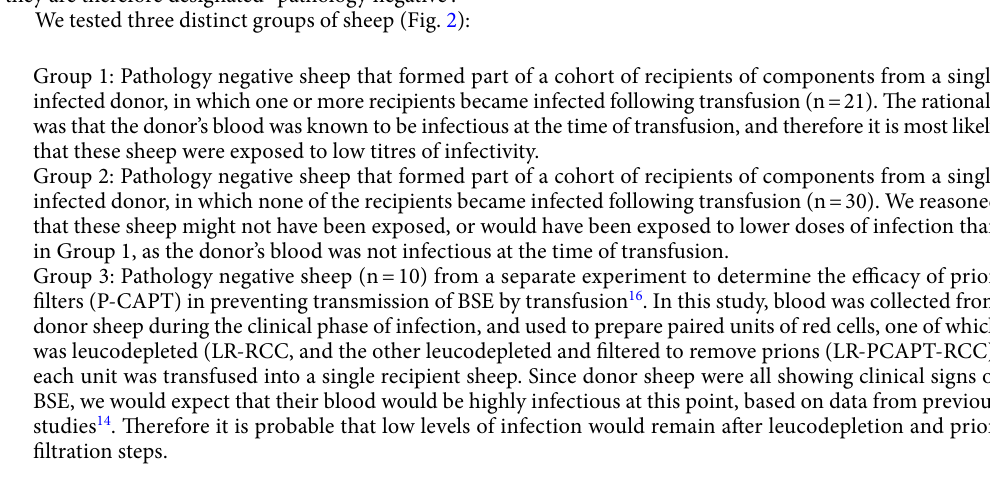
filtration steps.